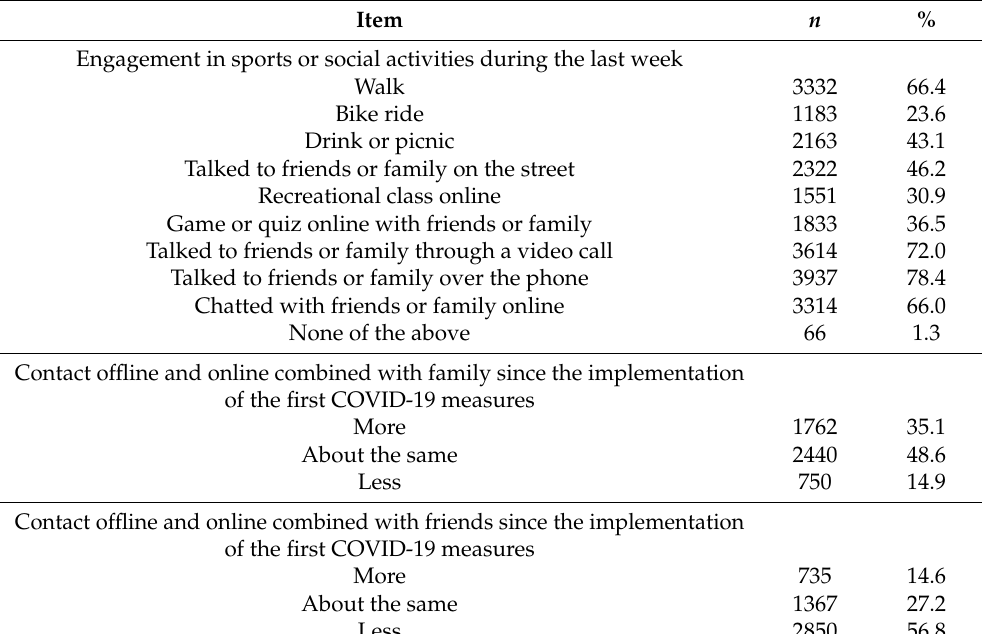
Table 3. Descriptive results regarding social activities and social contacts.